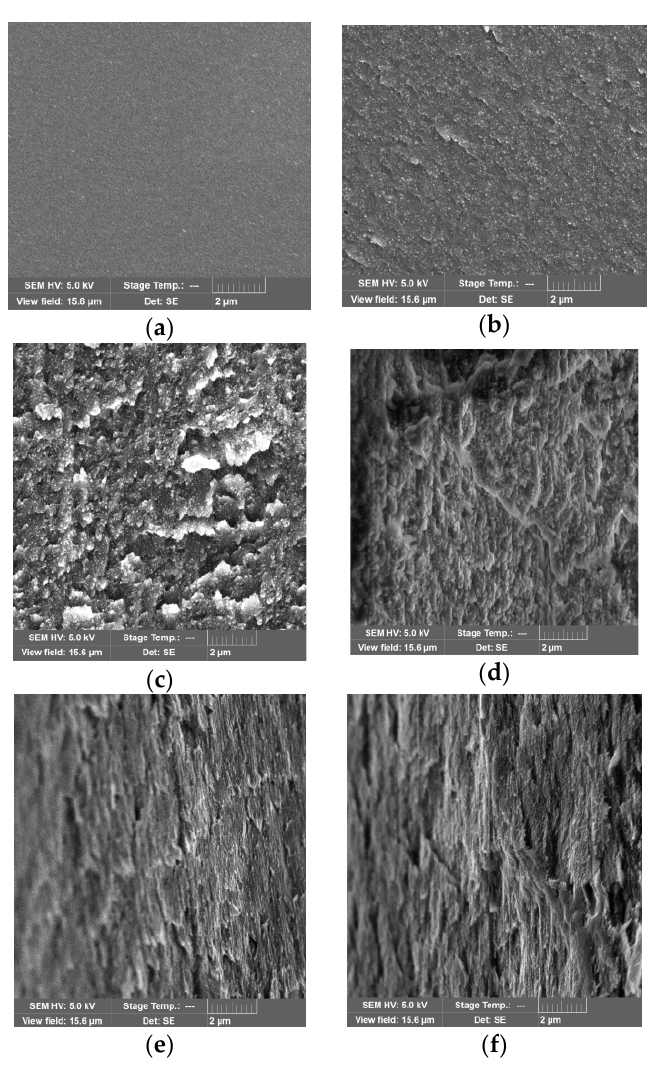
Figure 8. Cross-sectional SEM images of the neat PVP film ( a ) and the PVP/CNC composite films with CNC content (wt.%) of: 4.6 ( b ); 16.3 ( c ); 28.9 ( d ); 54.5 ( e ); 85.7 ( f ), respectively. The scale bar is 2 μ m.